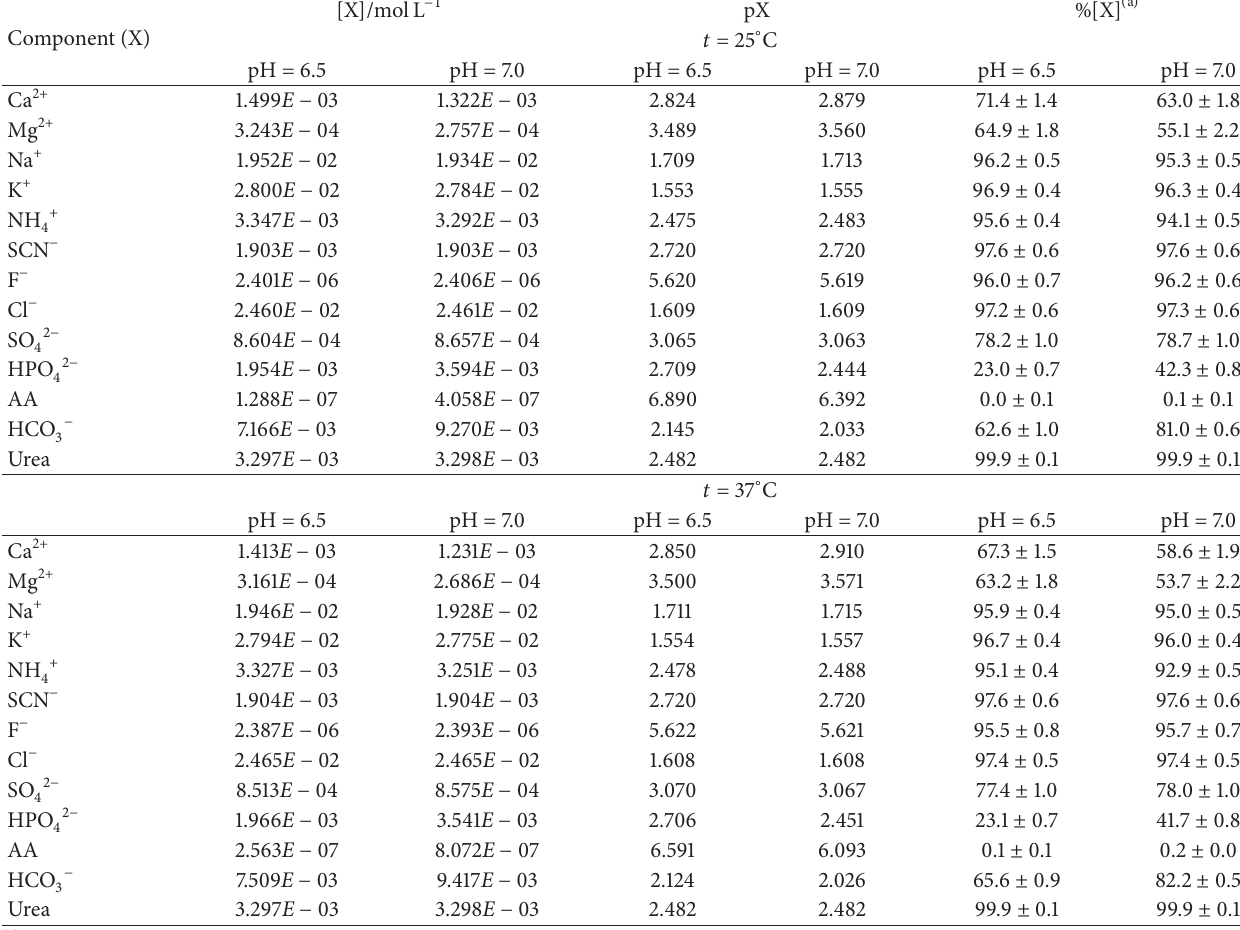
Table 5: Free concentrations of various components of synthetic saliva at 𝑡 = 25 and 37 ∘ C, at pH = 6.5 and 7.0. Component (X)